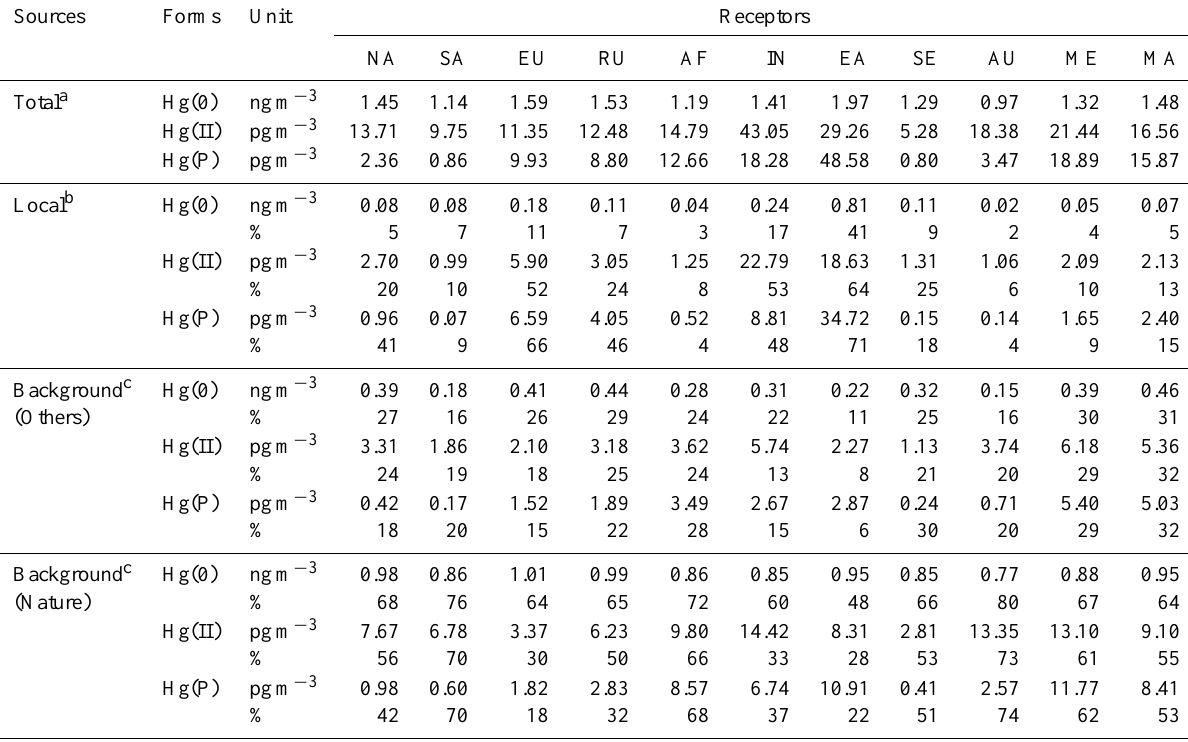
Table 1. Contributions from local and foreign sources to annual average A-W SMC (including Hg(0), Hg(II), Hg(P)) over each receptor region. The percent contributions (POC) that are defined using ratios of local or background to total are